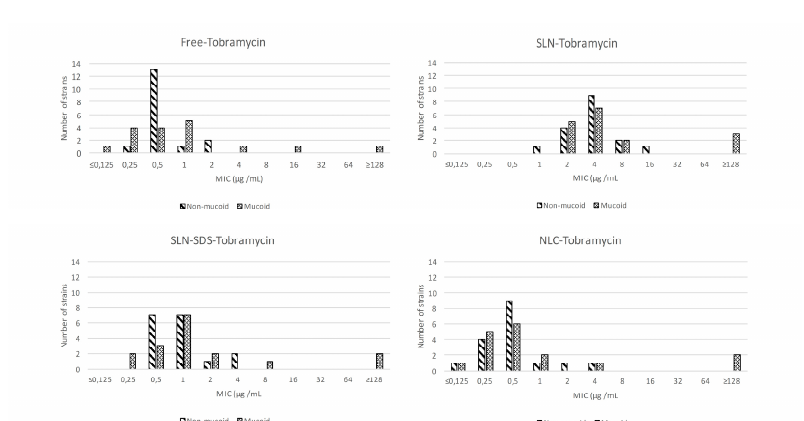
Figure 2. ( a ) The bioactivity (minimum inhibitory concentration, MIC) of lipid nanoparticles loaded with tobramycin in 34 strains of Pseudomonas aeruginosa isolated from the clinical samples of cystic fibrosis patients; ( b ) The same as in ( a ) but separated according to the 17 mucoid and 17 non-mucoid strains of the bacterium. For an explanation of the nanoparticles, see the text.